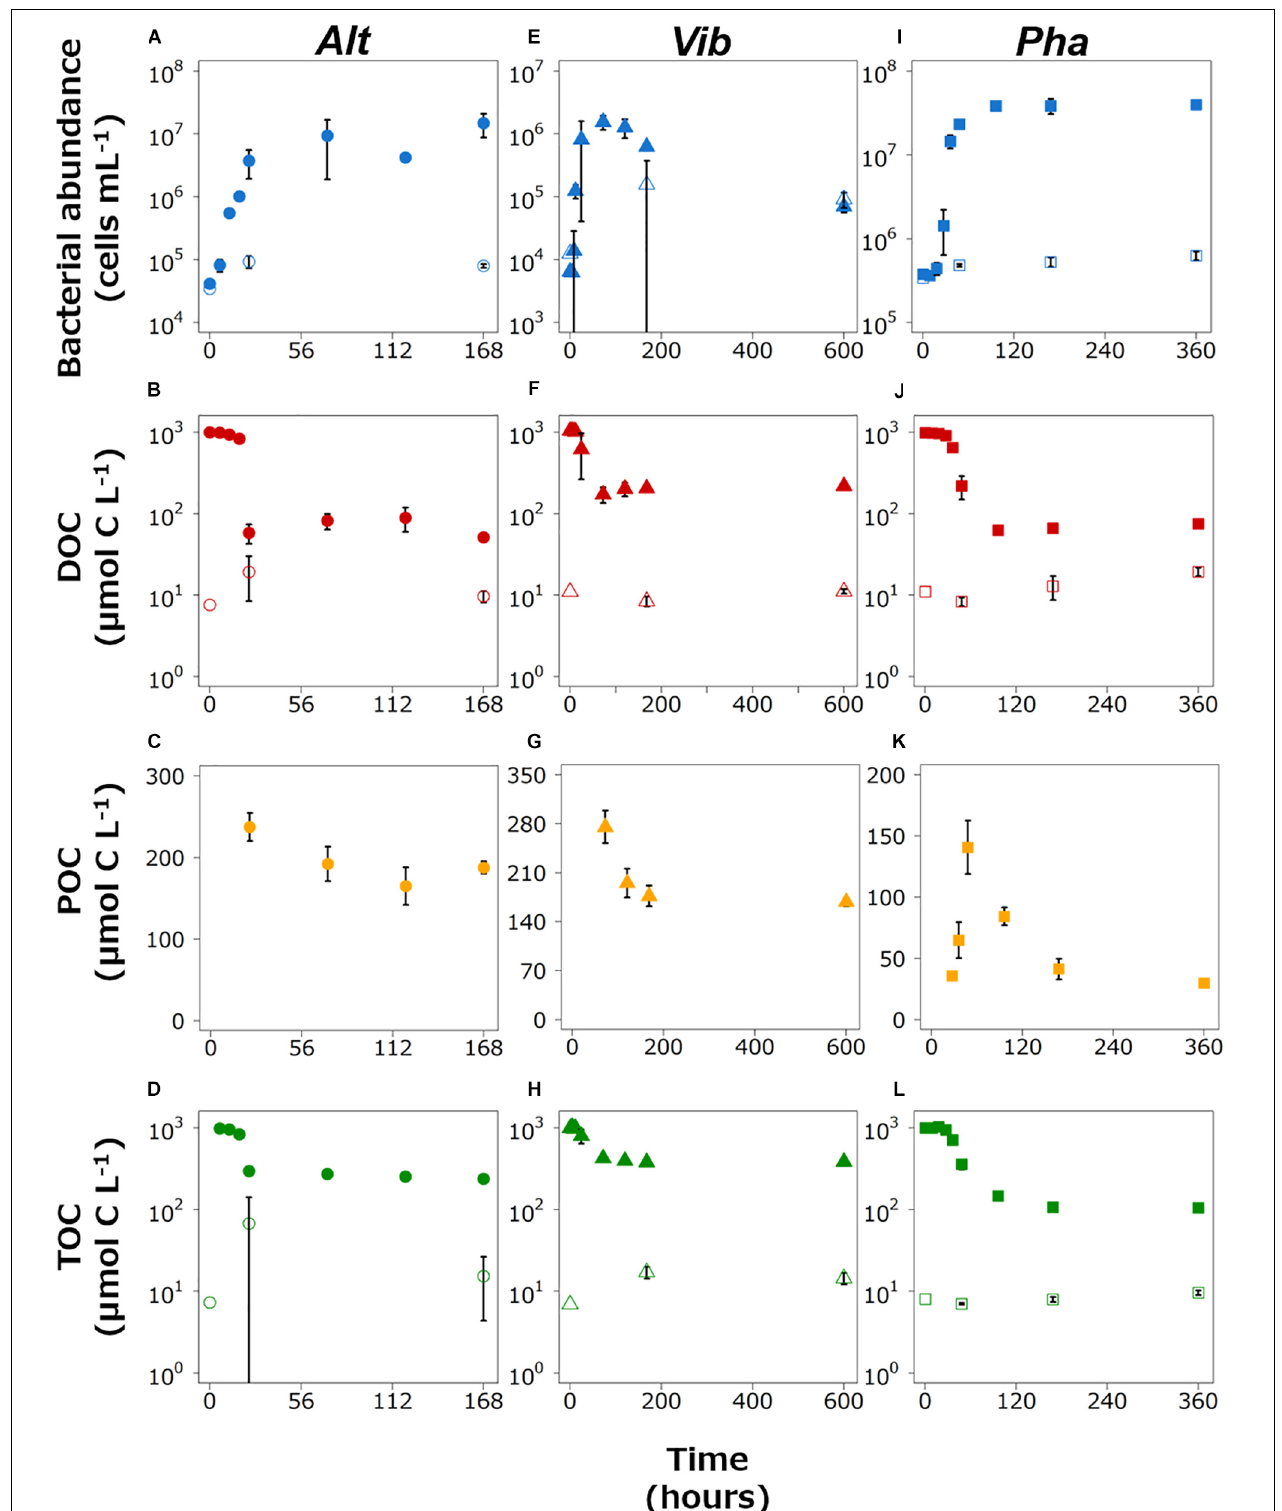
FIGURE 1 | Changes in the bacterial abundance and the concentrations of dissolved organic carbon (DOC), particulate organic matter (POC), and total organic carbon (TOC) in the Alt (A–D) , Vib (E–H) , and Pha (I–L) treatments, respectively. The closed and open symbols represent the experimental treatment and control treatment, respectively. The error bars indicate standard deviation of triplicate incubation